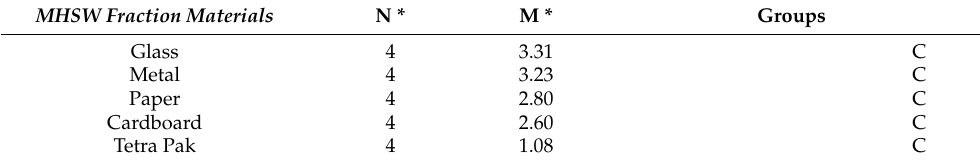
* N = Number of samples, M = Mean of the percentage values of MHSW fraction materials, Groups = Groups of MHSW fraction materials.